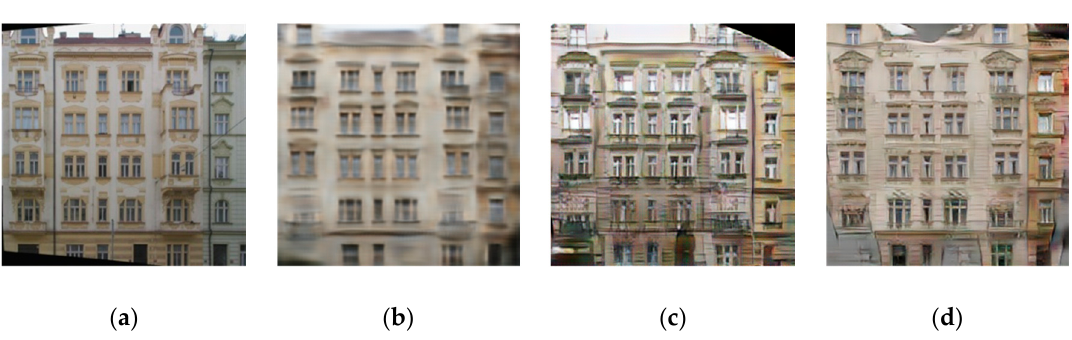
Figure 3. ( a ) ground-truth image, ( b ) image generated by conventional CNN using L1 loss function, ( c ) image generated by standard GAN using adversarial loss and ( d ) image constructed by the proposed method with Input-Perceptual and Reconstruction Adversarial losses